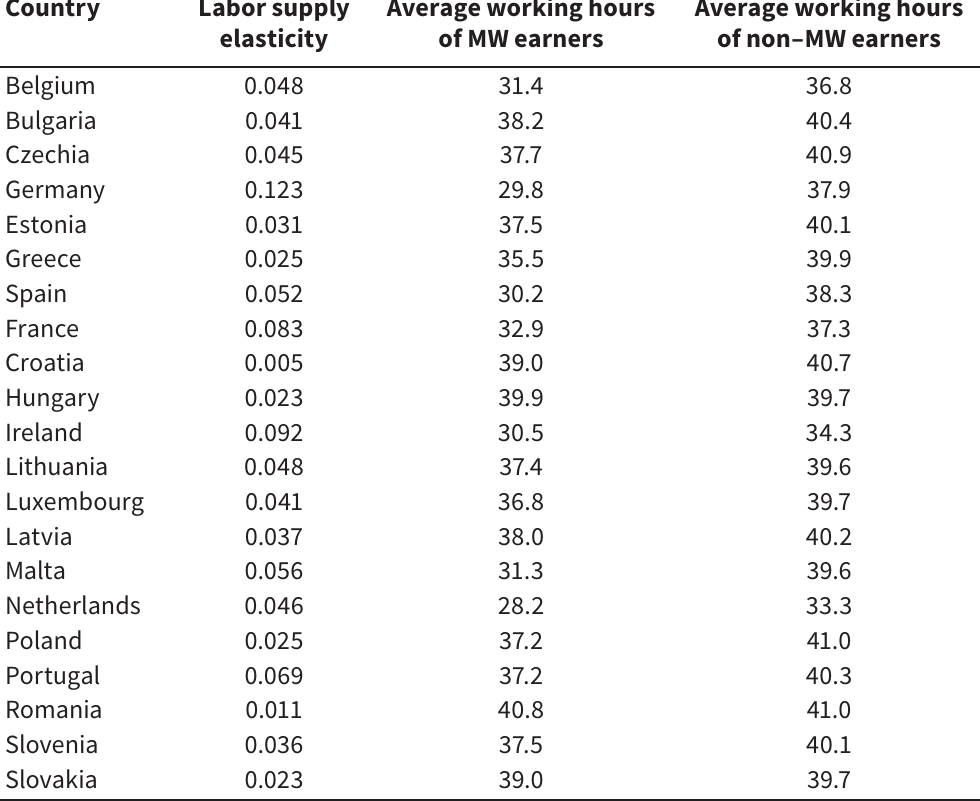
Labor supply elasticities and average working